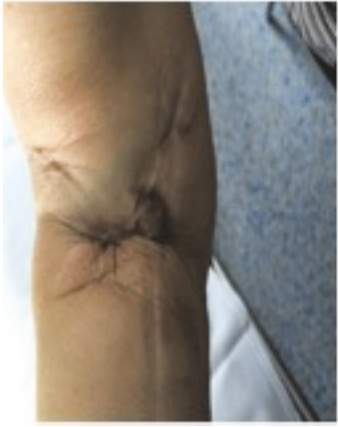
Figure 1: Macroscopic image of the right arm.